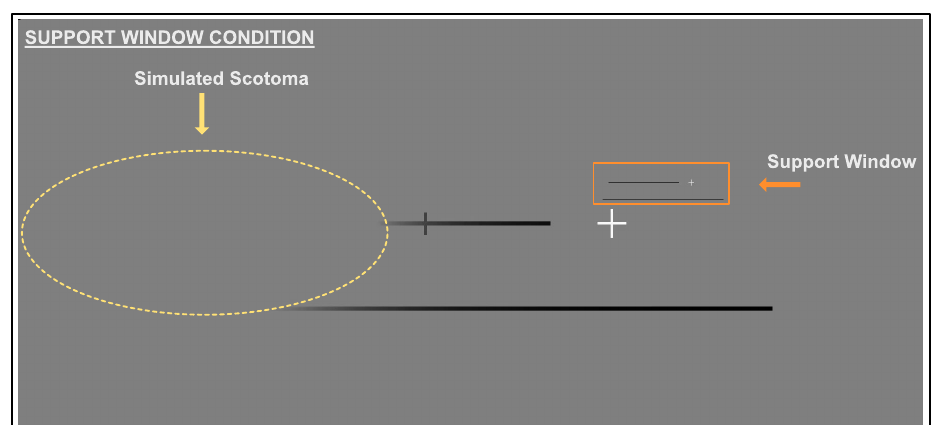
Figure 3. Augmentation Condition: In this final condition, the artificial scotoma was still present, but also included an image of the target and references lines was presented above fixation.